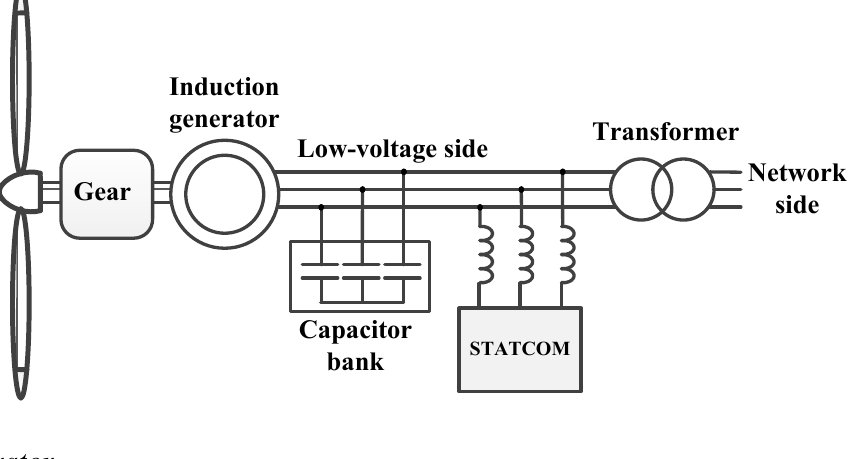
Figure 7. Configuration of the system to be analyzed.